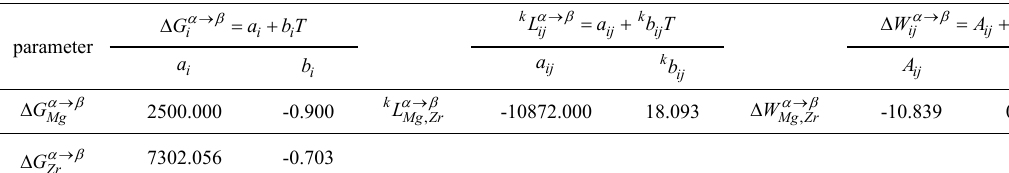
Table 2. Numerical values and functions used for the thermodynamic calculations.